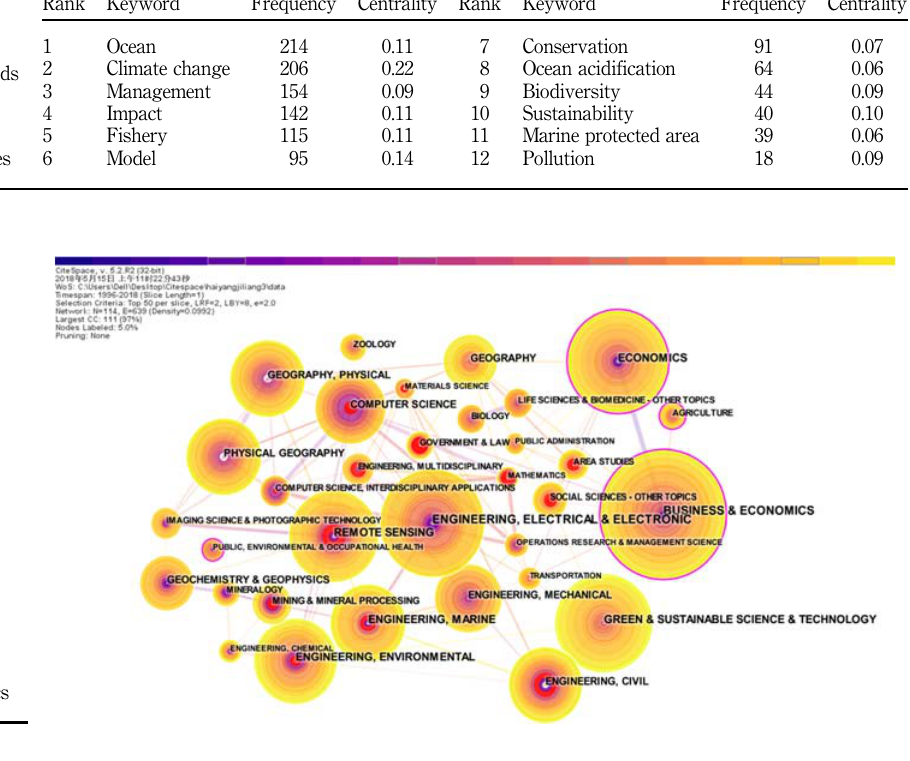
Figure 8. Related fields of marine